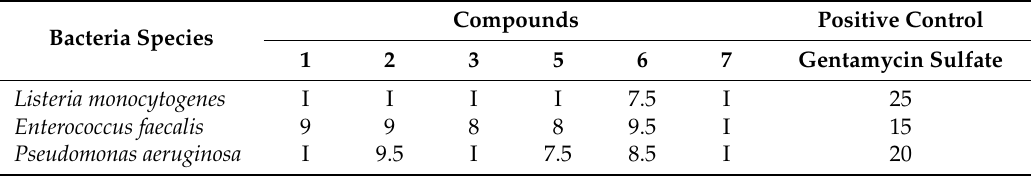
Table 3. Antibacterial activity of compounds 1 – 3 and 5 – 7 , inhibition diameter (mm).